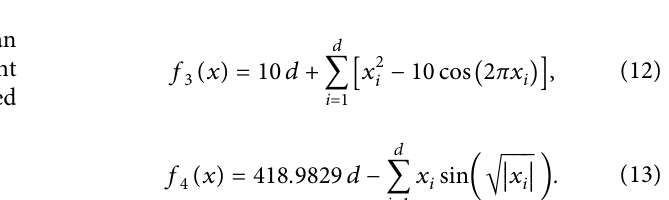
Figure 2: Self-training